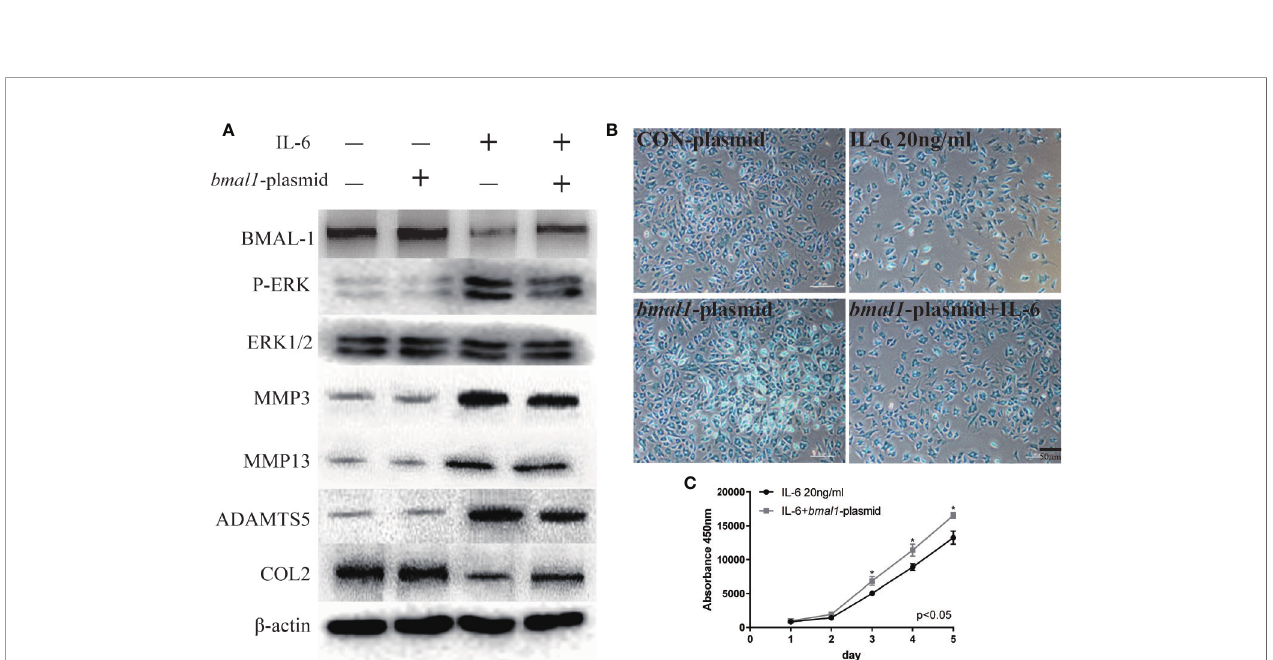
FIGURE 6 | IL-6-treated chondrocytes increase matrix degradation inhibited by BMAL-1. (A) MCCs transiently transfected with control plasmid or bmal1 plasmid were cultured in the presence of IL-6. Western blotting showed that IL-6-induced increases in P-ERK, MMP3, MMP9, and MMP13 were abrogated in BMAL-1- overexpressing cells, and IL-6-induced decreases in COL2 were reversed by the bmal1 plasmid. (B) Alcian blue staining results for MCCs transfected with 20 nM con plasmid or 20 nM bmal1 plasmid and stimulated with 20 ng/ml IL-6 for 12 h. (C) BMAL-1 overexpression enhanced MCC proliferation in medium containing 20 ng/ml IL-6, as determined by CCK-8 assays. All experiments were performed in triplicate, and the results are expressed as the mean ± SD. The P value is written in the fi gure corner. Scale bar: 50 mm.*P <